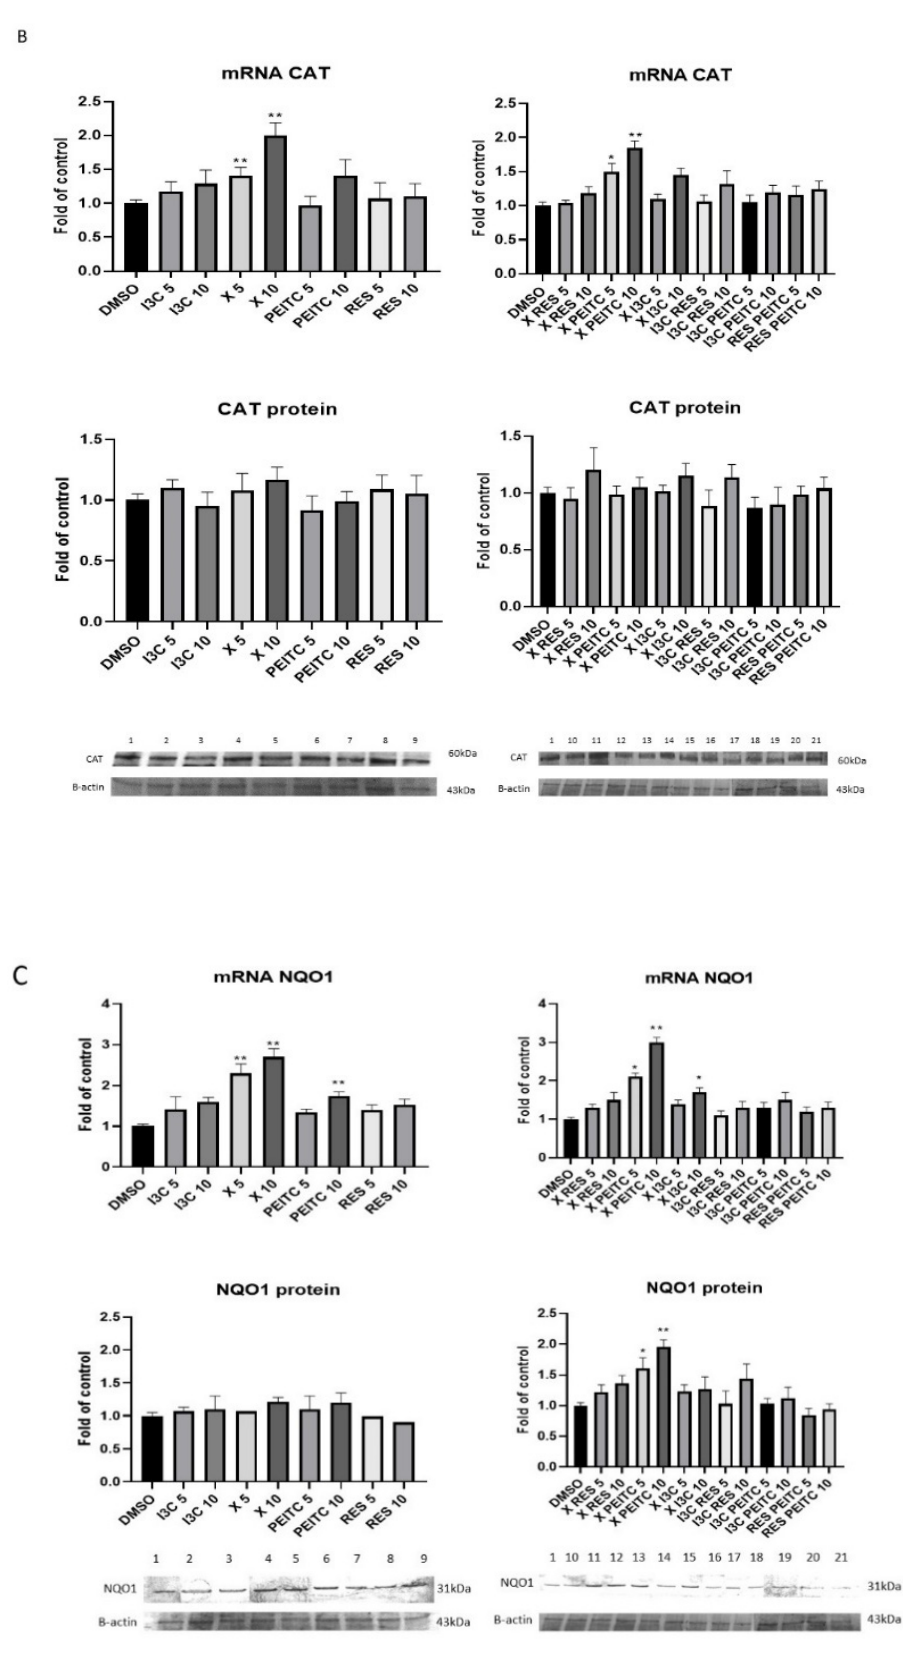
Figure 6. The impact of X, PEITC, RES, I3C, and their mixtures on the expression of Nrf2 target